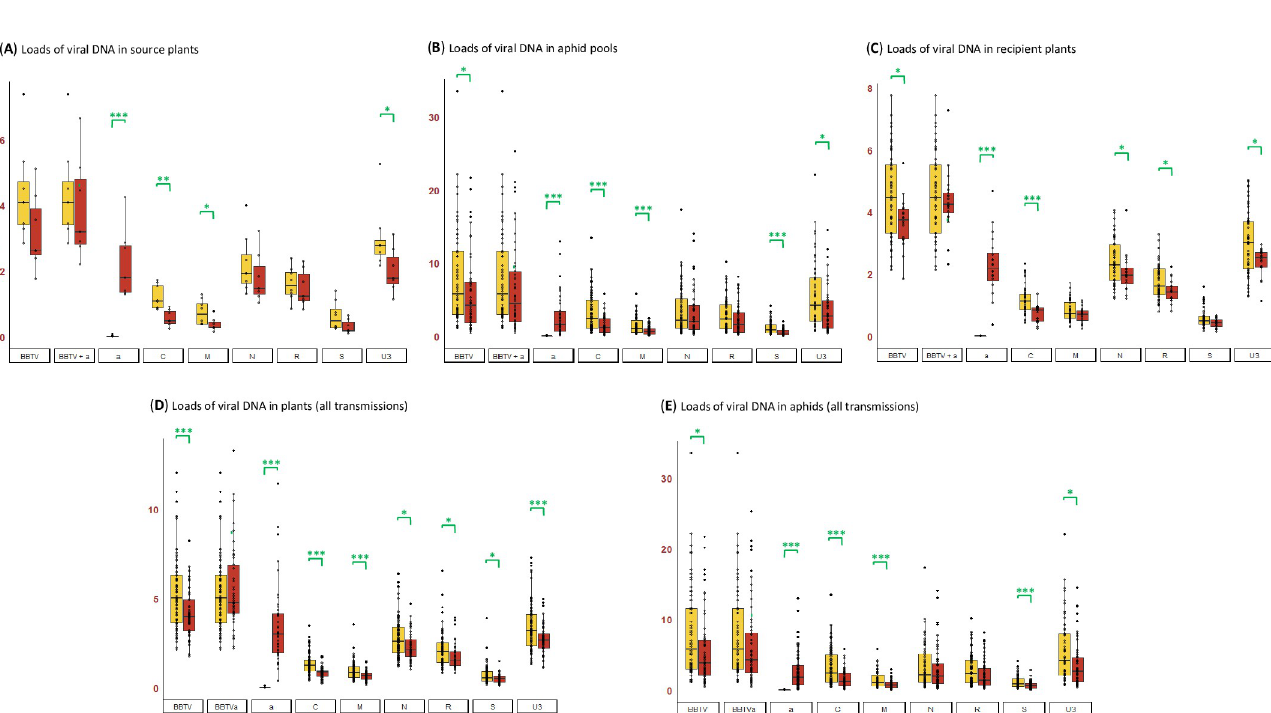
Fig 4. Impact of DRC alphasatellite on viral DNA loads in source plants, aphid pools and recipient plants. Viral DNA loads for each BBTV component (C, M, N, R, S, U3) and alphasatellite (a) as well as for total helper virus without (BBTV) or with (BBTVa) alphasatellite measured by quantitative PCR in ( A ) source plants without (n = 8) and with (n = 7) alphasatellite (transmission experiments C and D), ( B ) aphid pools without (n = 58) and with (n = 46) alphasatellite (experiments C and D), ( C ) recipient plants without (n = 52) and with (n = 20) alphasatellite (experiments C and D), ( D ) all plants without (n = 77) and with (n = 47) alphasatellite (all experiments) and ( E ) all aphid samples without (n = 58) and with (n = 56) alphasatellite (all experiments). � Kruskal-Wallis P < 0.05. ��� Kruskal-Wallis P < 0.005.